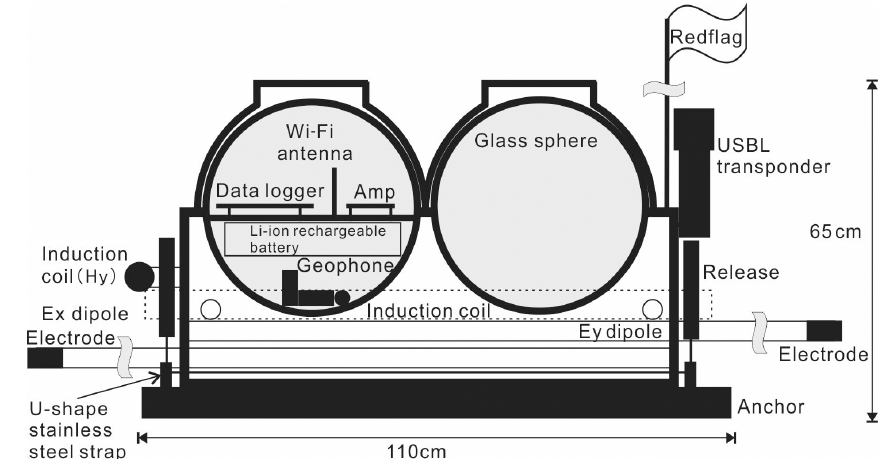
Figure 1. Schematic diagram of the ocean bottom electromagnetic receiver and seismometer (OBEMS). Diagram shows the structural design inside the glass sphere, with omnidirectional geophones in the lowest layer followed by the Li-ion rechargeable battery packs, acoustic telemetry modem (ATM), and the data logger. All print circuit boards are covered with magnetic shielding. Ferrite sheets, with a 0.01mm thick film on one side and a 0.02mm thick adhesive tape on the other, were glued inside the shielding box. These ferrite sheets function primarily as suppressors, blocking EM noise at lower frequencies and absorbing it at higher frequencies. A single U-shaped stainless steel strap connects the two release mechanisms, passing through two stainless steel loops set into the anchors.